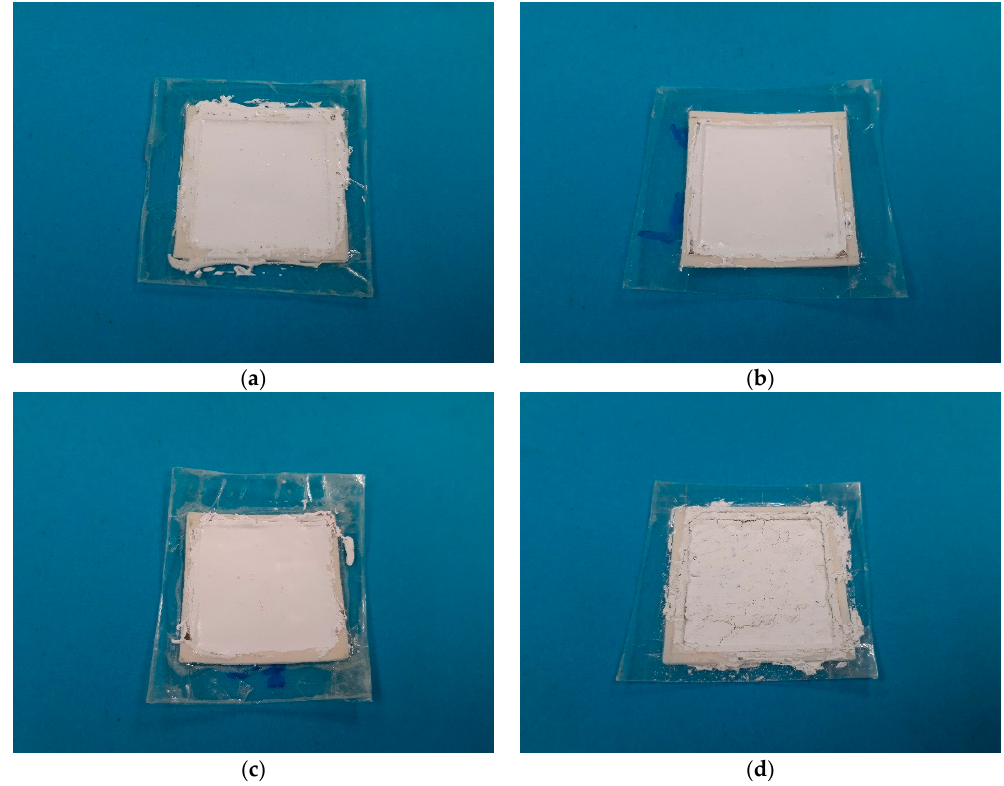
Figure 3. Photographs of four of the fabricated measurement samples of the dielectric paste: ( a ) 40% weight percent BST, ( b ) 60% weight percent BST, ( c ) 70% weight percent BST, and ( d ) 80% weight percent BST. With increasing BST content, the dried dielectric paste became more brittle.